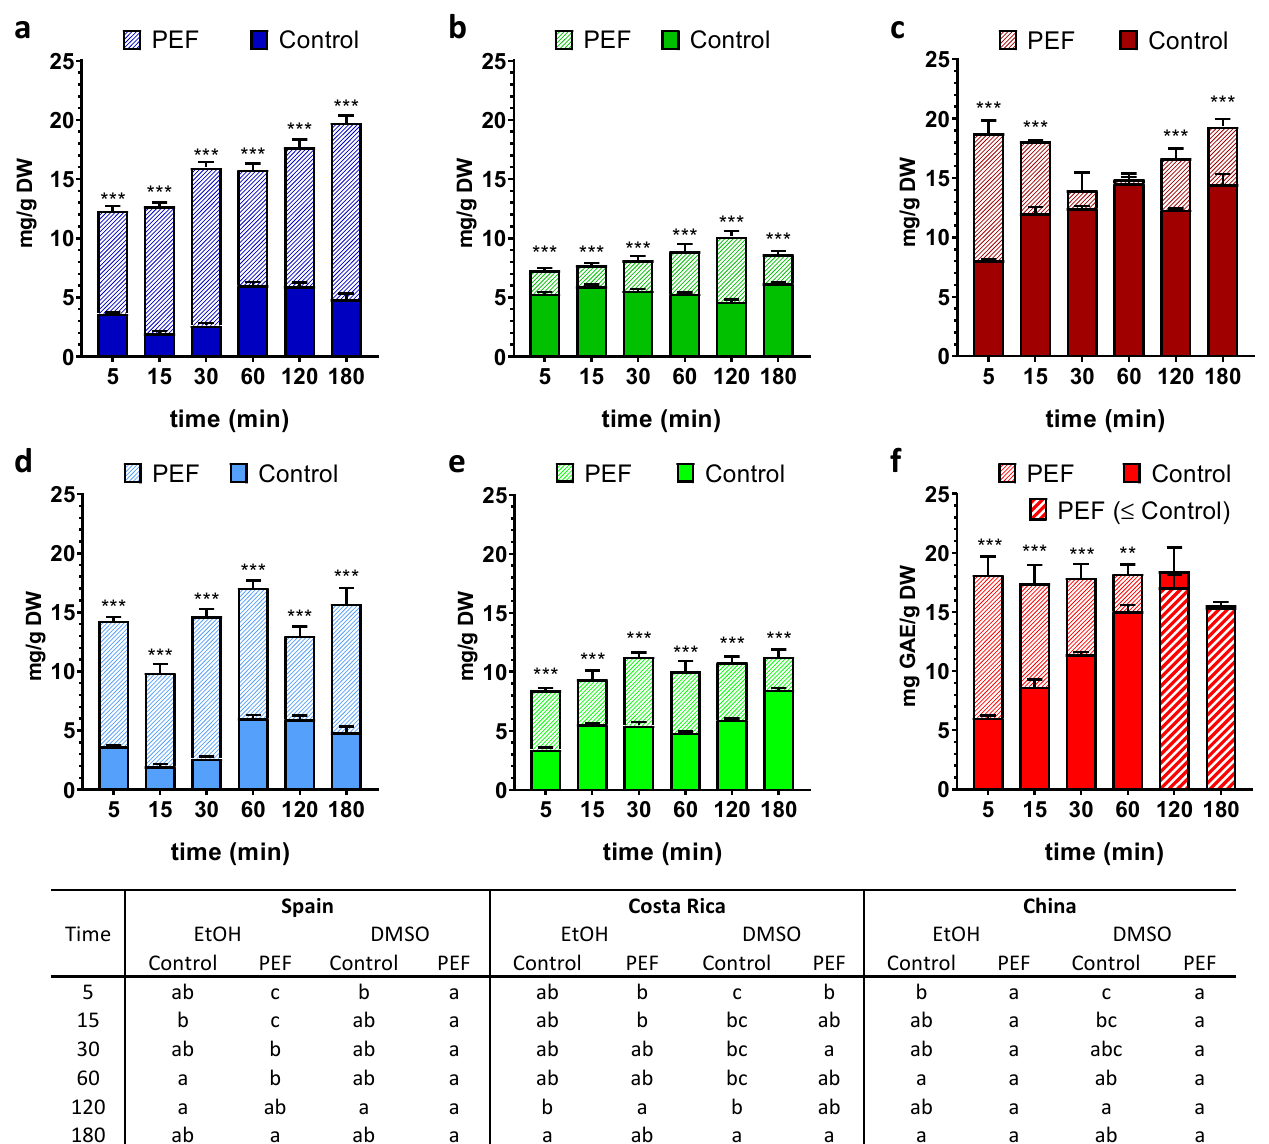
Figure 1. Total phenolic content of Spirulina extracts with PEF treatment or without PEF treatment (Control) for ethanol:water ( a – c ) and DMSO:water ( d – f ) solvent from Spirulina cultivated in different geographical regions (blue: Spain, green: Costa Rica, red: China). Statistical differences related to the PEF treatment are represented by asterisks (*). Statistical differences related to the extraction time are represented by different lower-case letters in the table. ** = p < 0.01; *** = p < 0.001.